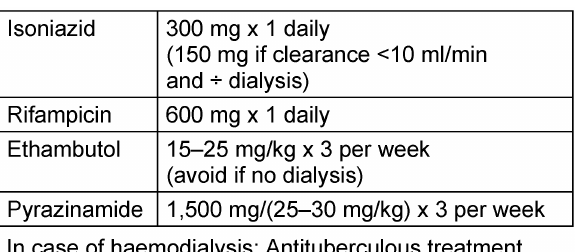
Table 4: Reduced kidney function (creatinin